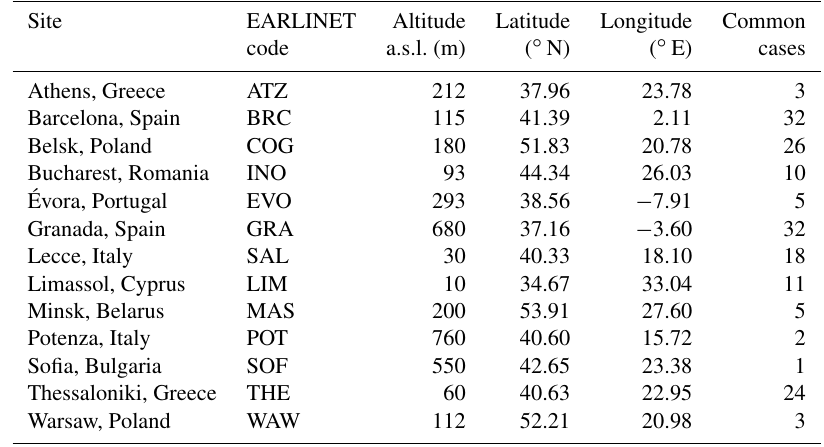
Table 2. Locations of EARLINET lidar stations order by site, with their geographical coordinates and GOME-2/MetOp cases considered in the validation process.